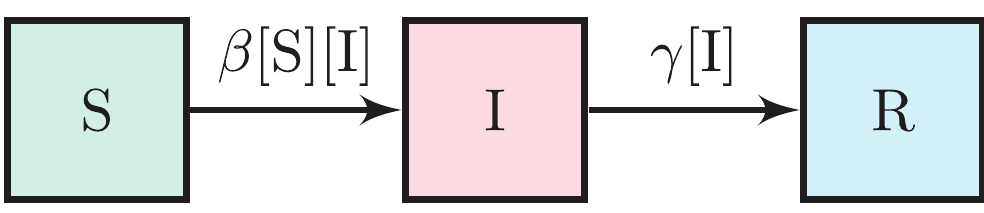
Figure 1 The SIR model. The boxes represent the set of susceptible, infectious, and removed individuals. The arrows represent fl ow and are annotated with per capita fl ow